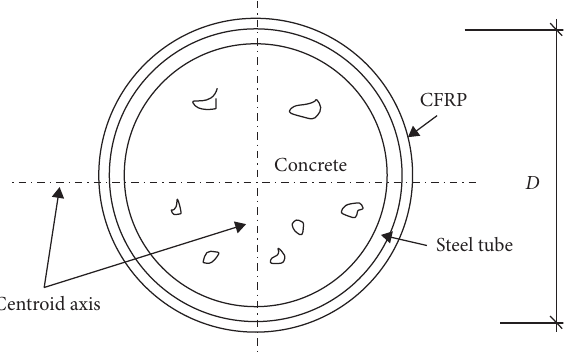
Figure 3: Section diagram of C-CF-CFRP-ST specimens.